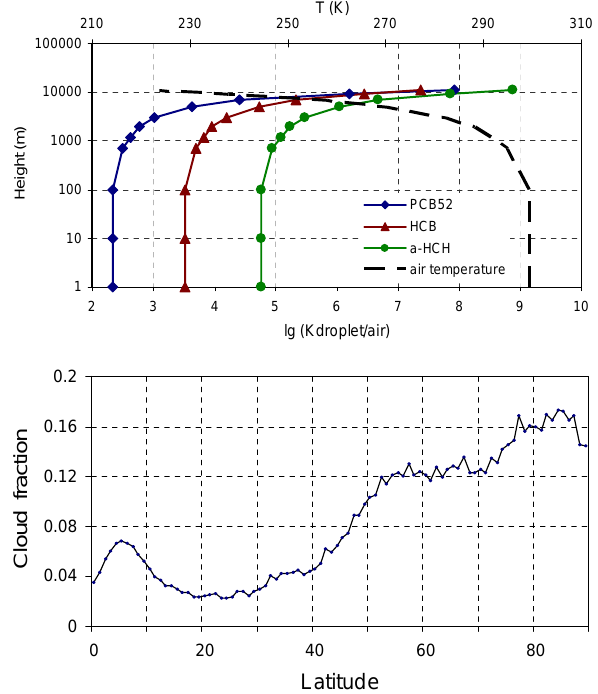
Fig. 10 Fig. 10. (a) Vertical profile of temperature dependent air-cloud droplet partitioning lg K droplet / Air for PCB52, HCB and α -HCH at 10 ◦ N. lg K Droplet / Air at value of 5.5–7.5 indicates the transition from vapour to aqueous phase. The vertical profile in the zonally- averaged mean air temperature, averaged over 1950–1980, as shown in Fig. 1, is also presented (black dashed line). The upper x-axis in- dicates air temperature and lower x-axis indicates lg K Droplet / Air . (b) Modeled mean annual cloud fraction (%) at 3000m height av- eraged over the Northern